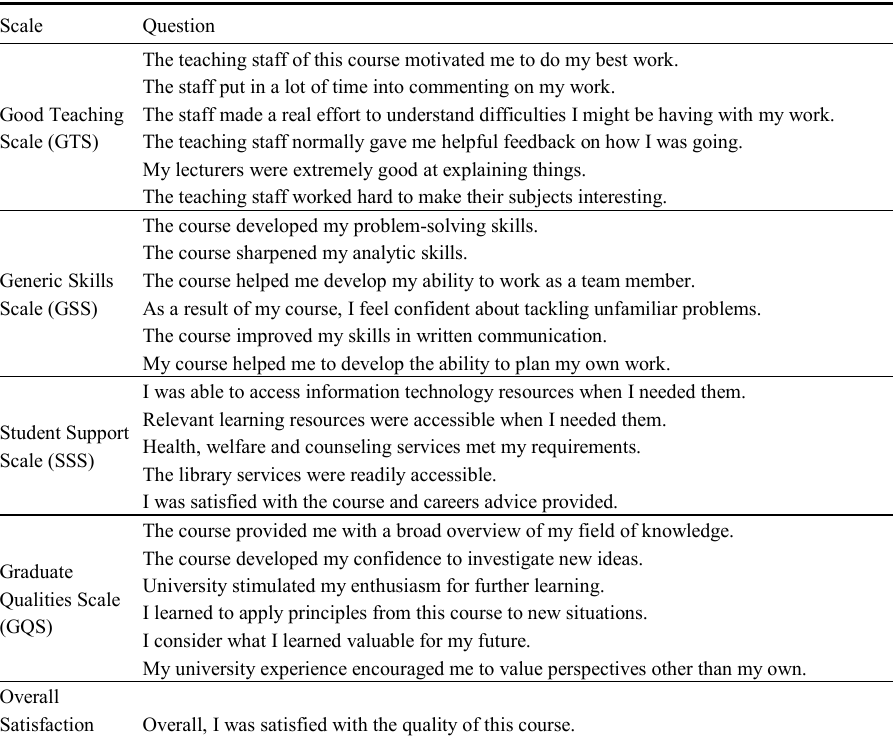
Table 1. Basic form of the